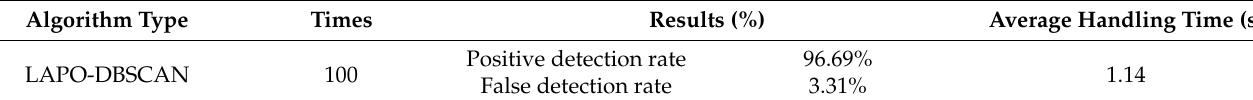
Table 5. Actual scene test results.